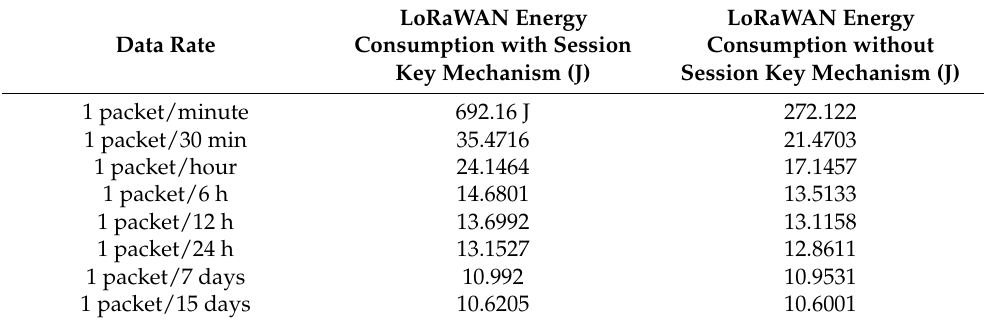
Table 3. LoRaWAN Energy Consumption